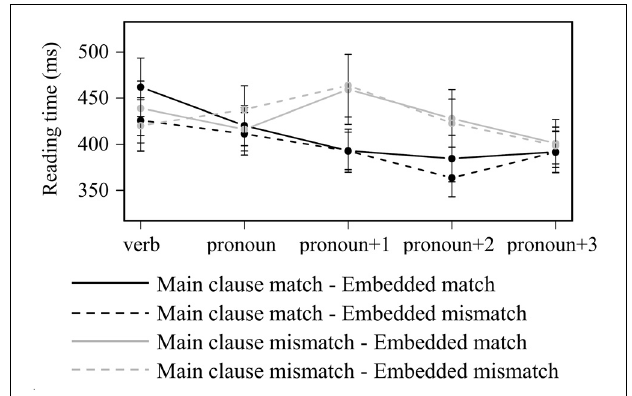
FIGURE 2 | Word-by-word reading times for all items in Experiment 2. Error bars indicate standard error of the participant mean.